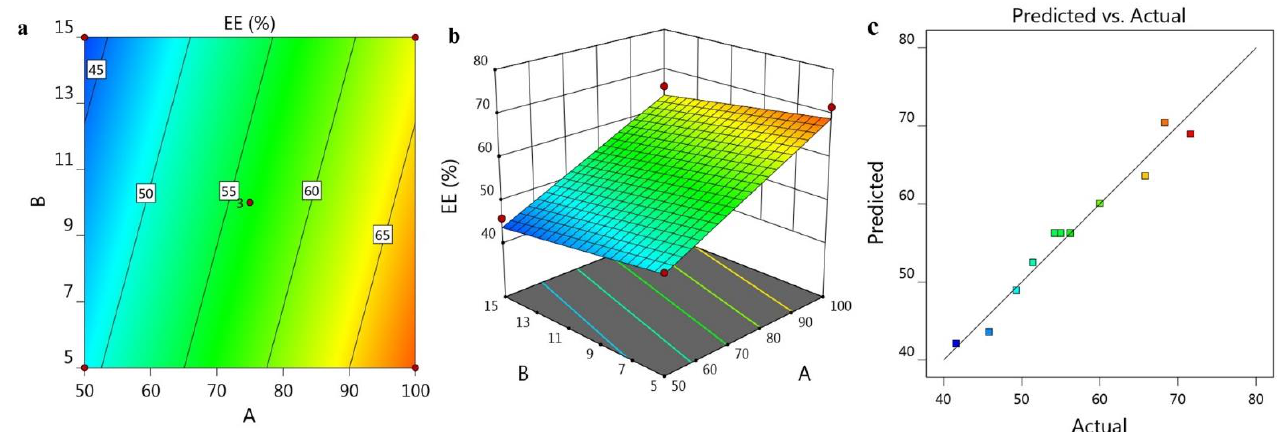
Figure 2. Representing ( a ) 2D-Contour plot, ( b ) 3D-Response Surface Plot and ( c ) linear correlation plot between predicted against actual values.